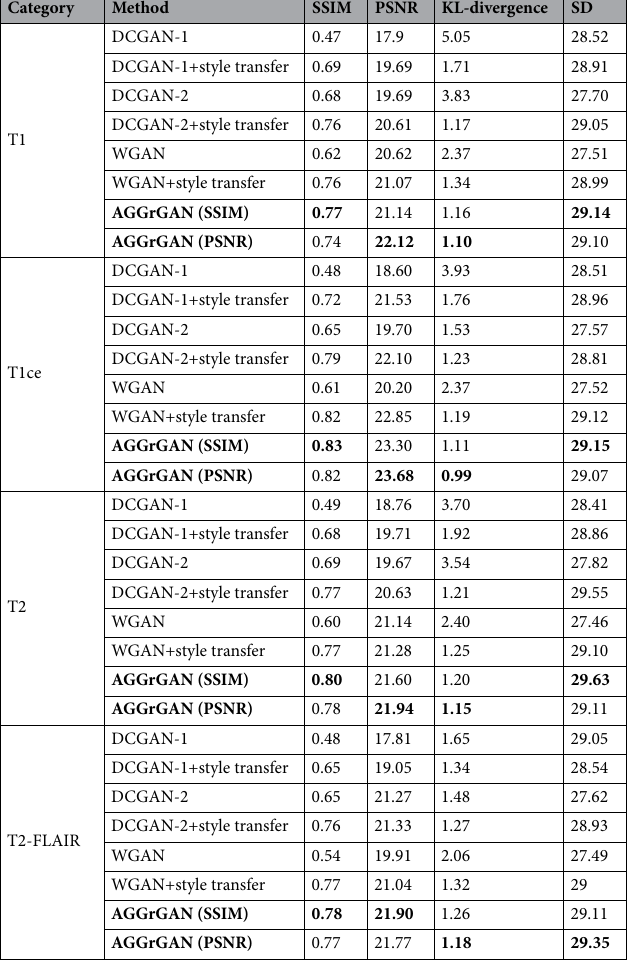
Table 2. Performance of the base GAN models along with AGGrGAN applied on the BraTS 2020 dataset. Values in bold signify that they are—(i) the metric-wise best value obtained for the corresponding class for Tables 1, 2, 3, 4 and (ii) case-wise best performance obtained for a particular